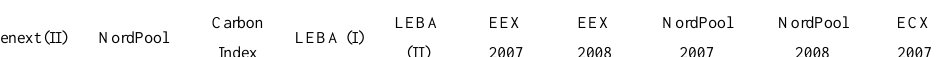
Table 5. Cross correlation analysis between European markets. Panel A: Price Correlation.